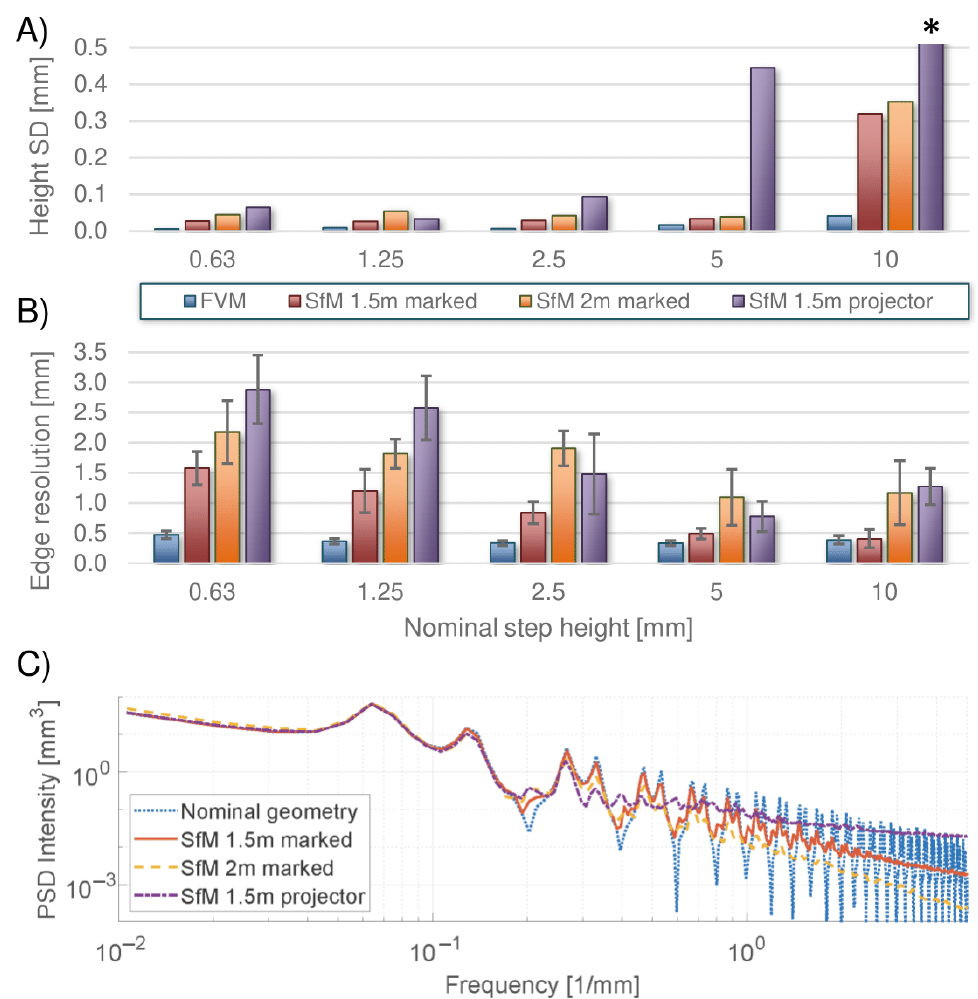
Figure 6. Step height artifact parameters from FVM, SfM marked pattern at 1.5 m and 2.0 and SfM projected pattern at 1.5 m. ( A ) SD of measured step height. Note that the SD of the 10 mm step of the SfM projected pattern was cropped off at 0.5 mm for better visual comparison. ( B ) measured ER with the SD as errorbar. ( C ) Power spectral density (PSD) analysis of the full reconstructed step-height artifact. Both intensity and frequency are shown on a log-scale. SfM measurements are compared to a nominal PSD based on the design